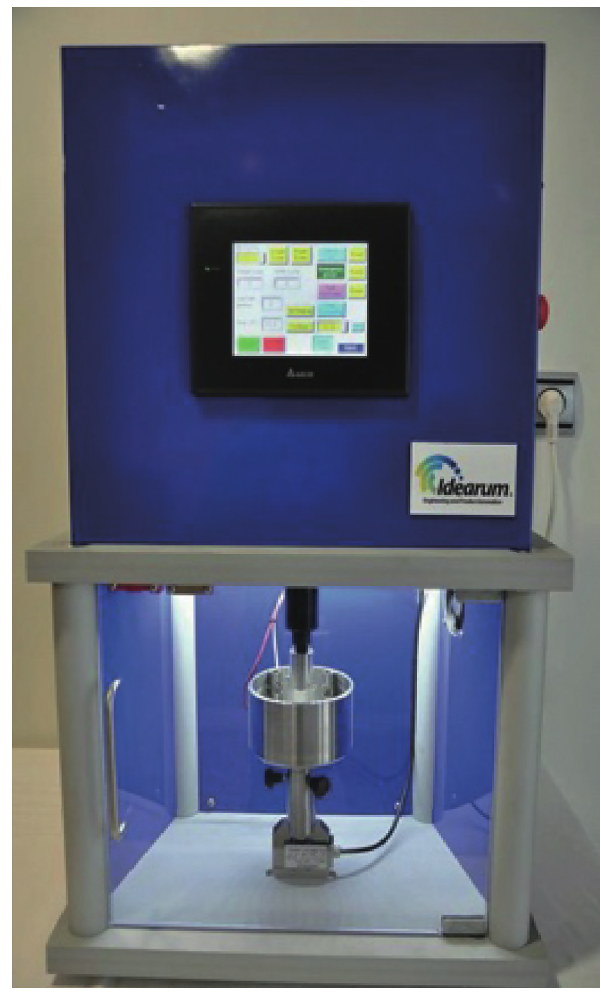
Figure 7: Dental CS ® test